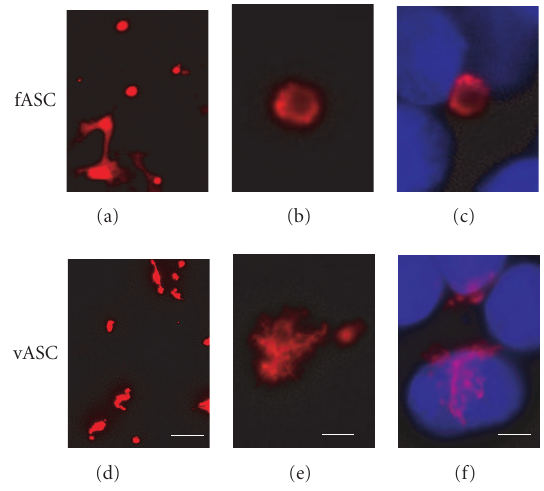
Figure 5: Intracellular distribution of fASC and vASC in Cos7 cells. Expression vectors of fASC or vASC were transfected into Cos7 cells. (a), (d): aggregation of fASC and vASC, scale bar: 30 μ M. (b), (e): magnified pictures of (a) and (d), scale bar: 5 μ M. (c), (f): aggregations with nuclei, scale bar: 5 μ